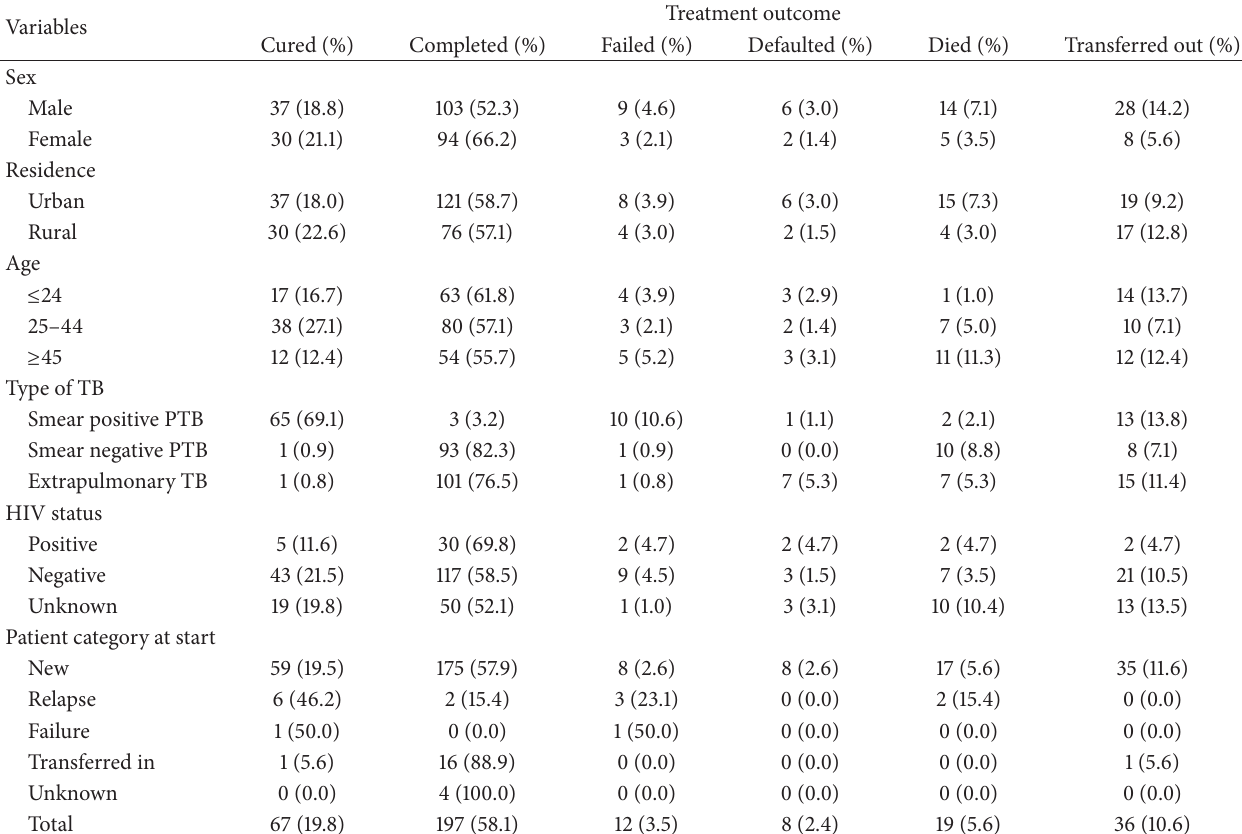
Table 3: Characteristics and treatment outcome of TB patients at Debre Tabor,